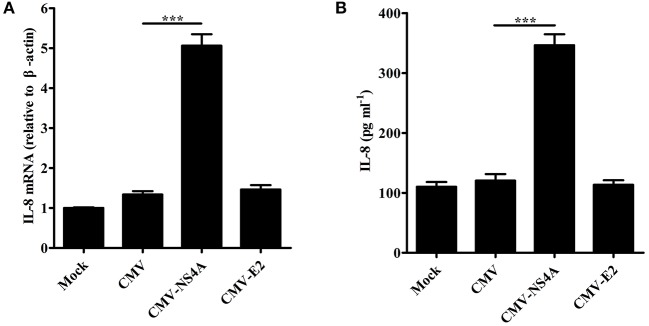
CSFV NS4A induces IL-8 production. (A,B) IL-8 mRNA expression and secretion in NS4A-transfected SUVECs. SUVECs were transfected with CMV-NS4A or CMV-E2 for 30 h and analyzed for IL-8 production by real-time PCR and ELISA. Error bars represent the mean ± SD (n = 3). ***P < 0.001.